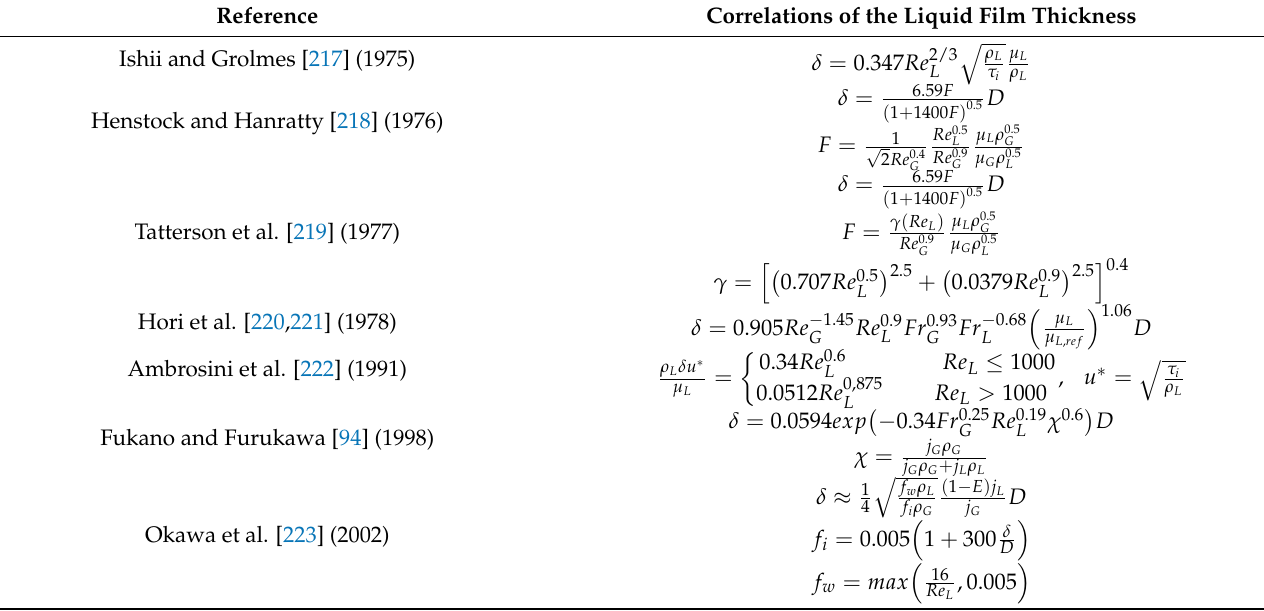
Table 1. Correlations of the average liquid film thickness of annular two-phase